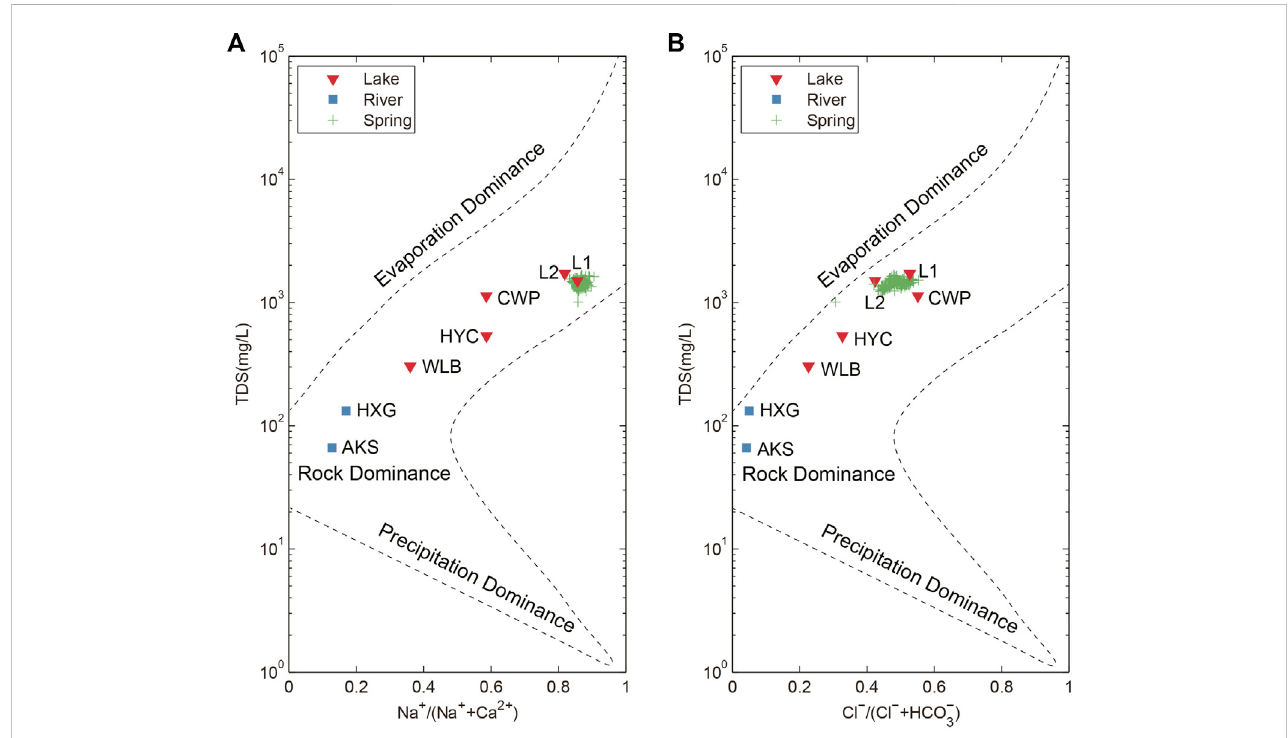
FIGURE 3 Gibbsplotsofgroundwaterandsurfacewatersamplesinthestudyarea: (A) Na + /(Na + +Ca 2+ )and (B) Cl − /(Cl − +HCO 3 − ) versus totaldissolvedsolids(TDS).